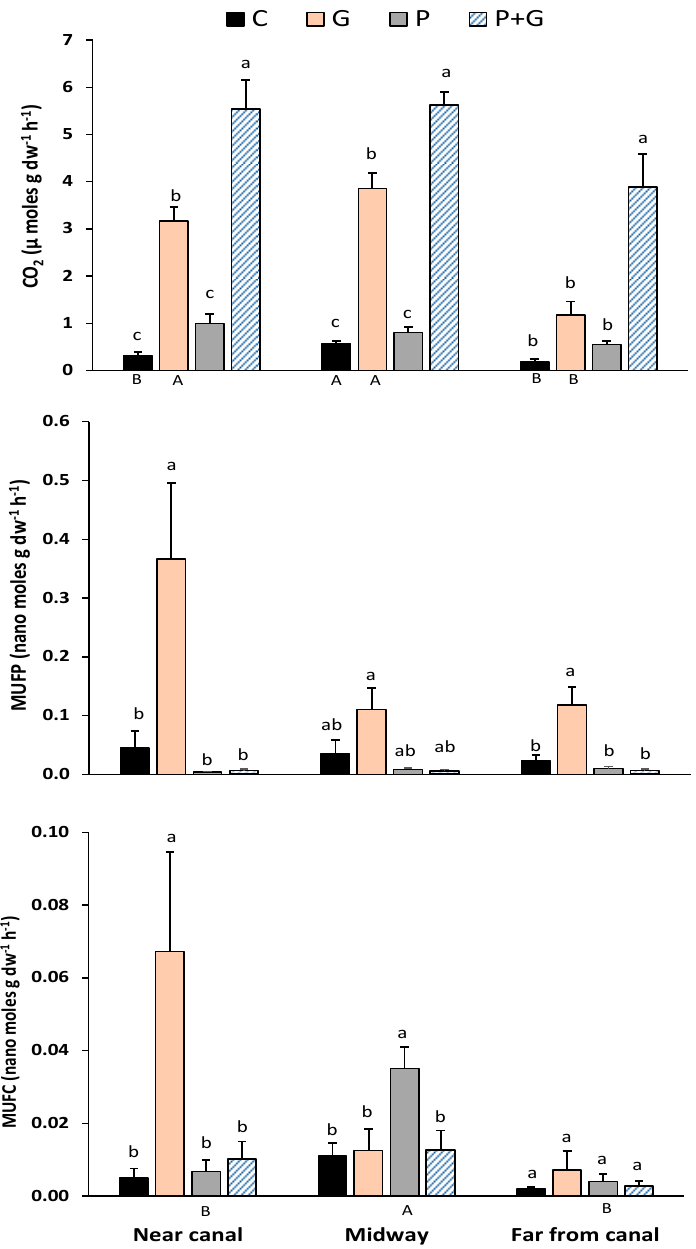
Figure 2. Carbon dioxide (CO 2 ) efflux and enzyme activity (phosphatase or MUFP and glucosidase or MUFC) analyses of incubated soil slurries collected at certain distances (near-canal, midway, and far from canal) downstream from the inflow in the Northeast Shark River Slough, ENP. Treatments included a control (C), glucose (G), phosphorus (P), and a combination of phosphorus and glucose (P + G). Lowercase letters indicate significant differences ( p < 0.05) between treatments (within a distance), while uppercase letters indicate the treatment difference sacross distances (NC, M, and FC). Uppercase letters not used in this figure were for treatments with no significant difference between